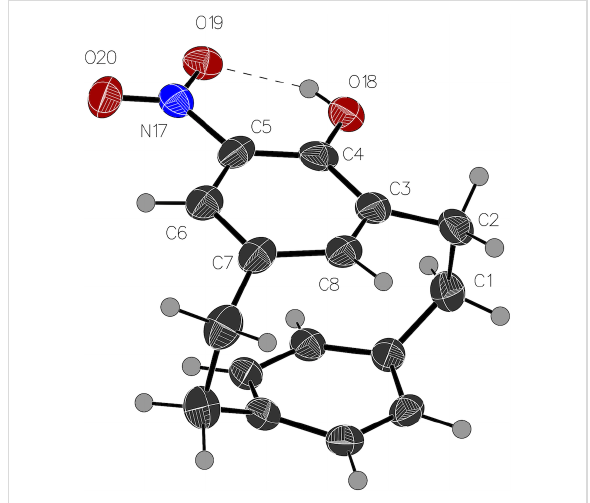
Figure 2: Crystal structure of 5 . Ellipsoids are drawn at a 50% proba- bility level [63-66].